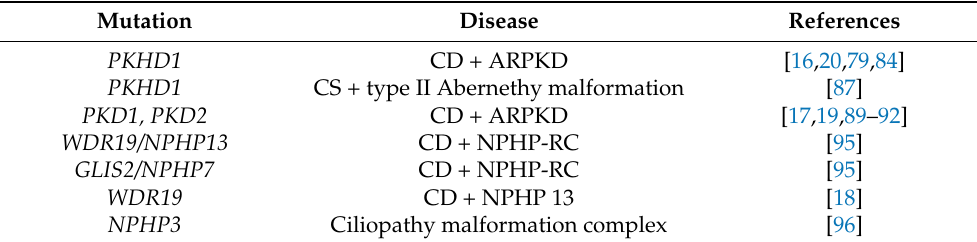
Table 2. Gene mutations relevant to CC associated with other anomalies. Mutation